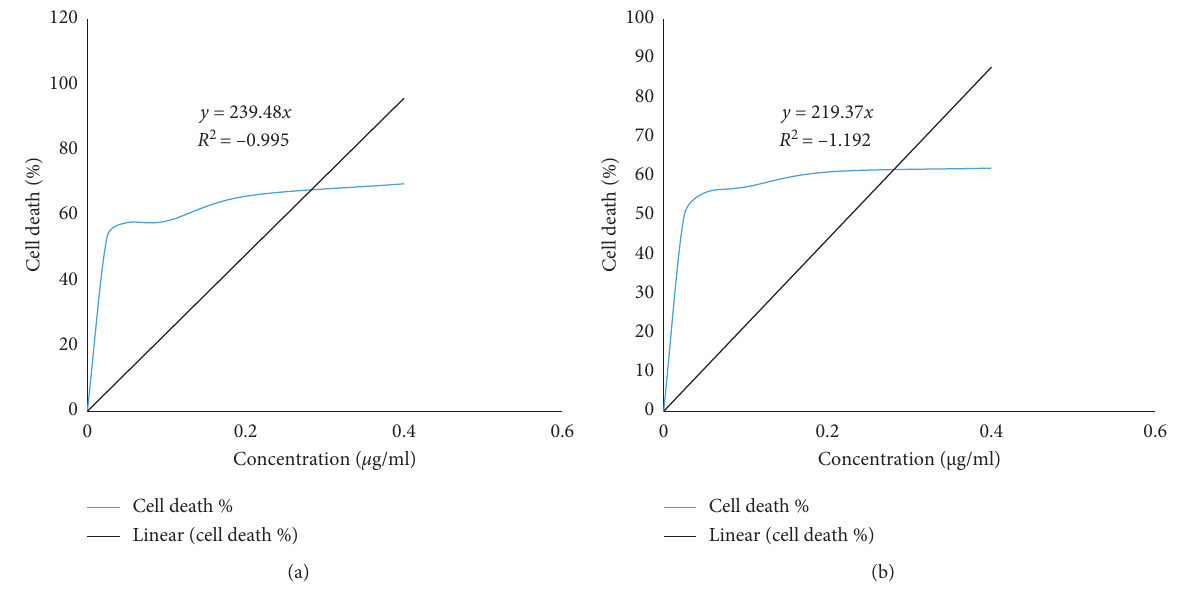
Figure 1: Acute toxic effect (cell death %) of the examined pesticides: (a) imidacloprid and (b) glyphosate on WPM-Y.1 cell line after 24h exposure estimated as IC 50